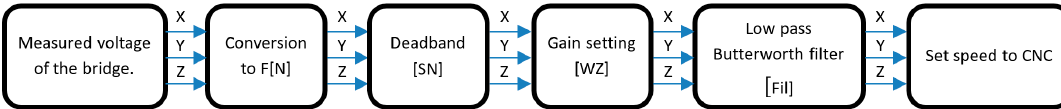
Figure 5. Scheme for converting measuring signals from levers into speed values for the X , Y and Z axes.